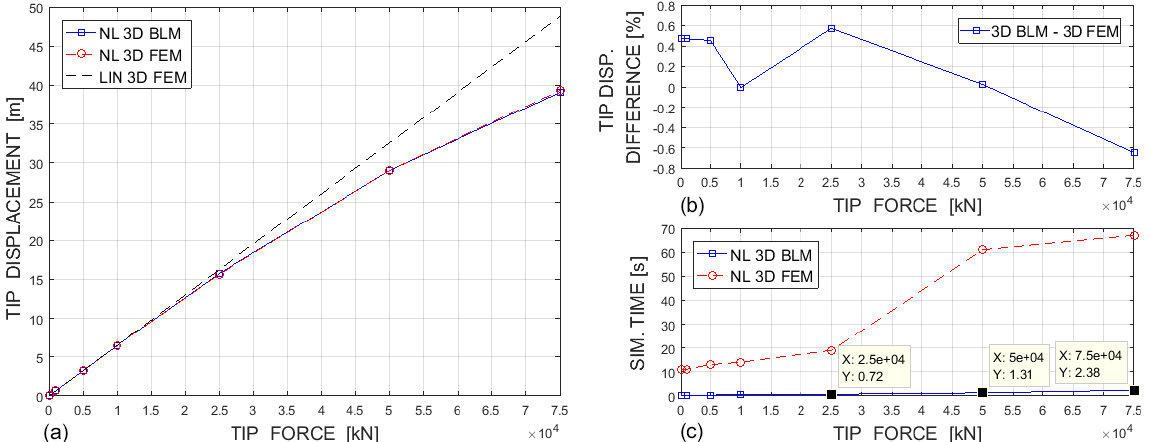
Figure 4. Comparison of tip displacements (a) , tip displacement differences (b) and simulation times (c) .